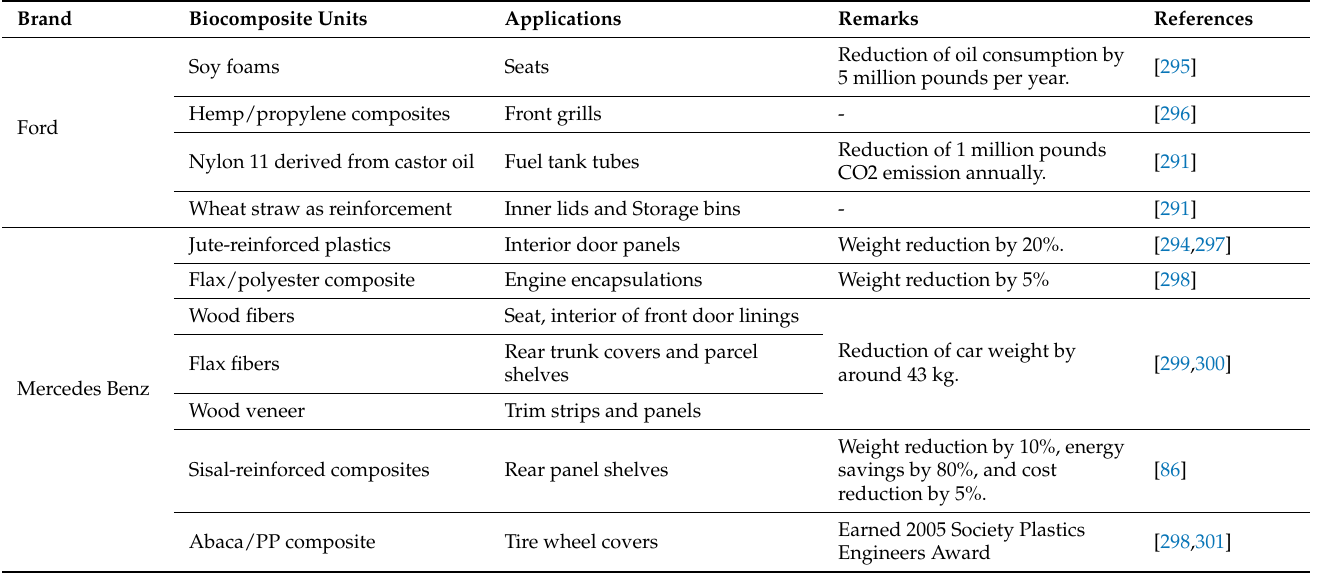
Table 7. Biocomposites in automotive